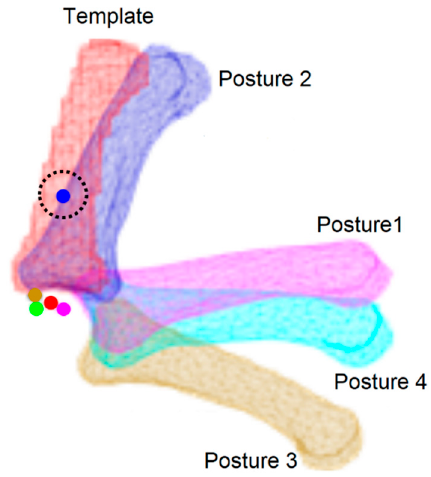
Figure 1. Estimated locations of finite joint centers of rotation of the proximal interphalangeal joint of the middle finger between different postures with an error highlighted in a dotted circle by Figueroa et al.’s method (adapted).